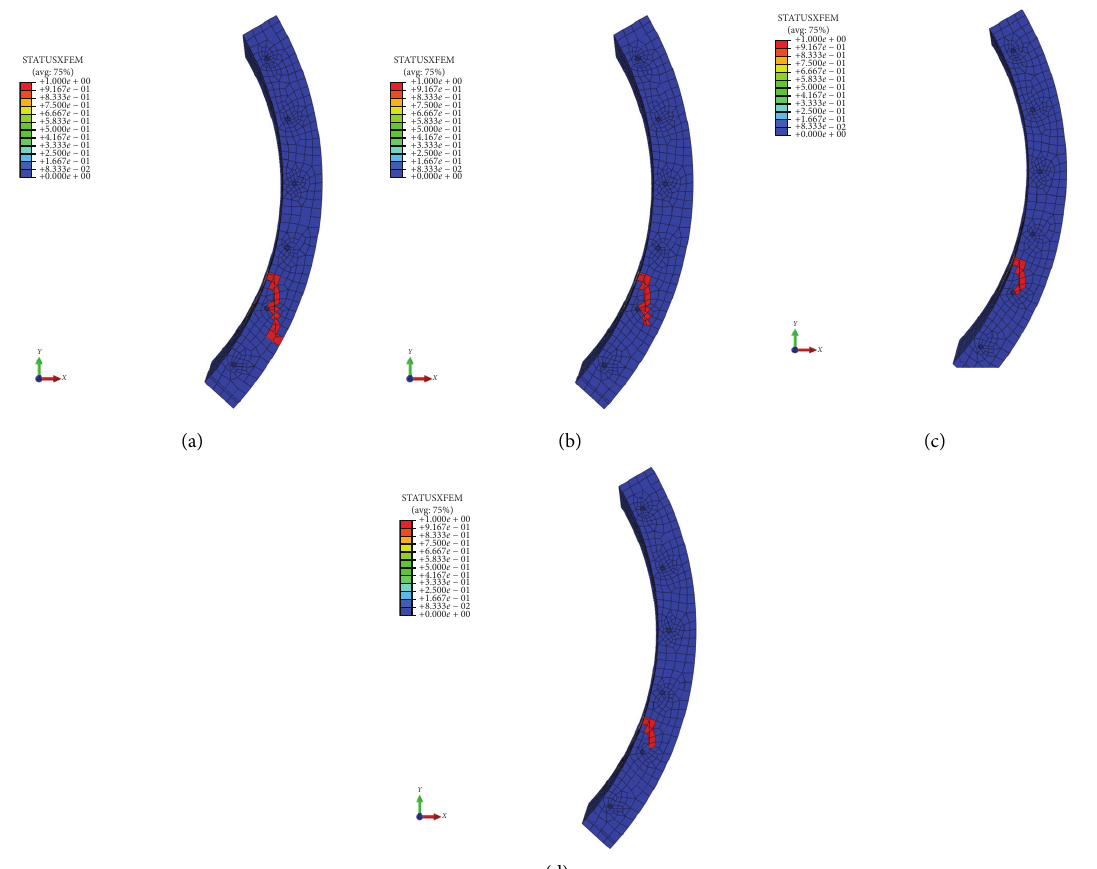
Figure 9: The final crack in the shied segment under different train axles: (a) 18t; (b) 16t; (c) 14t; (d) 12t.